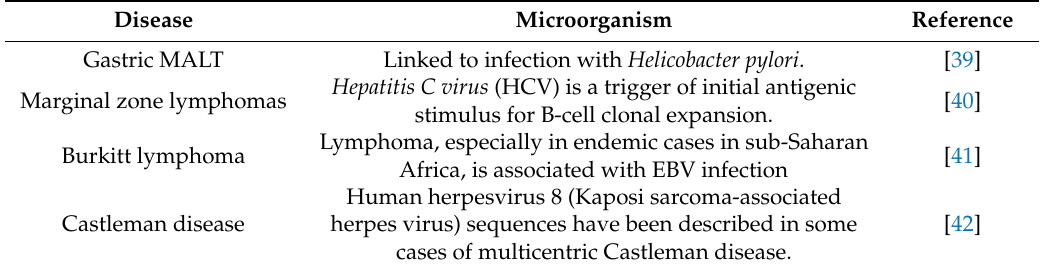
Table 1. Described associations between specific microorganisms, and lymphoid malignancies . 205 Disease Microorganism Disease Linked to infection with Helicobacter pylori Gastric MALT